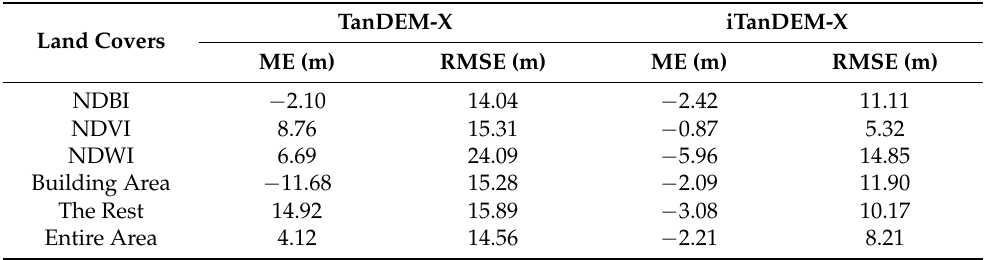
Table 5. The error patterns of TanDEM-X and iTanDEM-X for different land covers in Singapore. Land